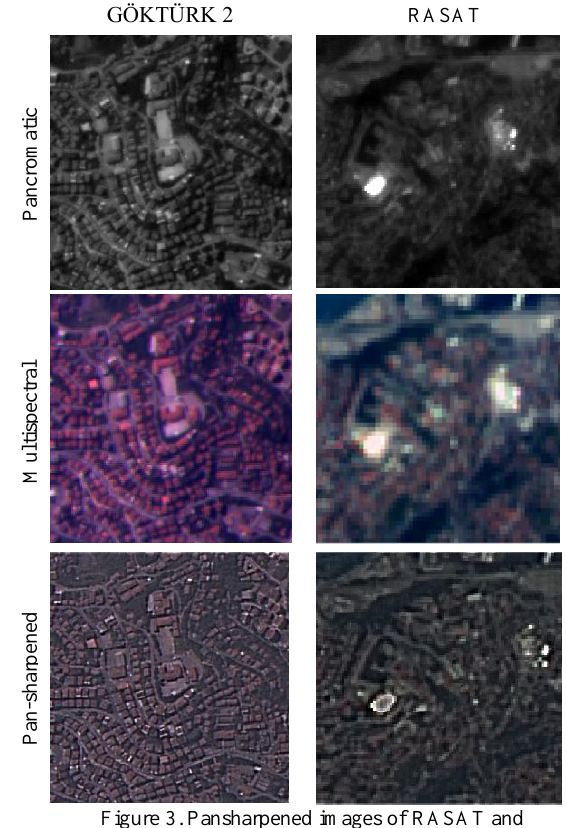
Figure 3. Pansharpened images of RASAT and GÖKTÜRK-2.